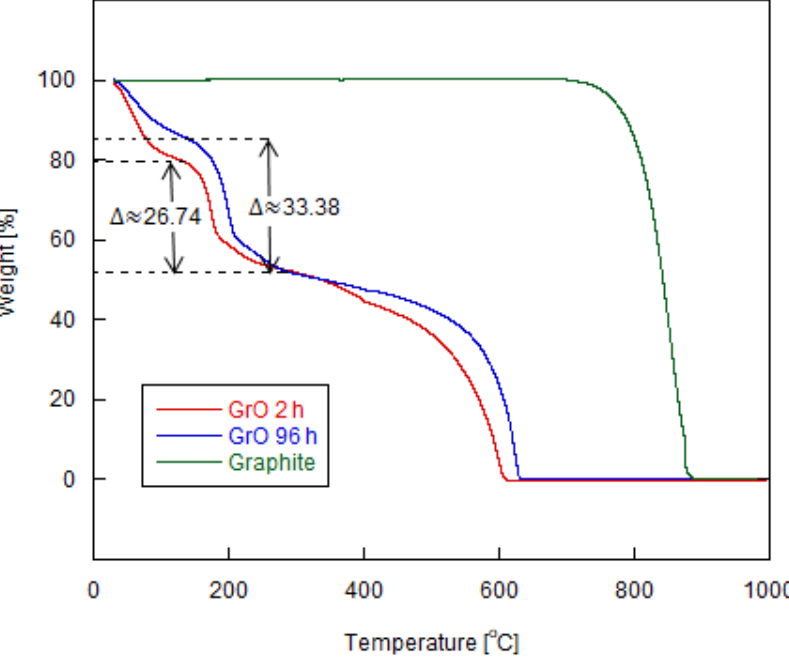
Figure 4. Thermogravimetric curves for Graphite, GrO 2 h and GrO.